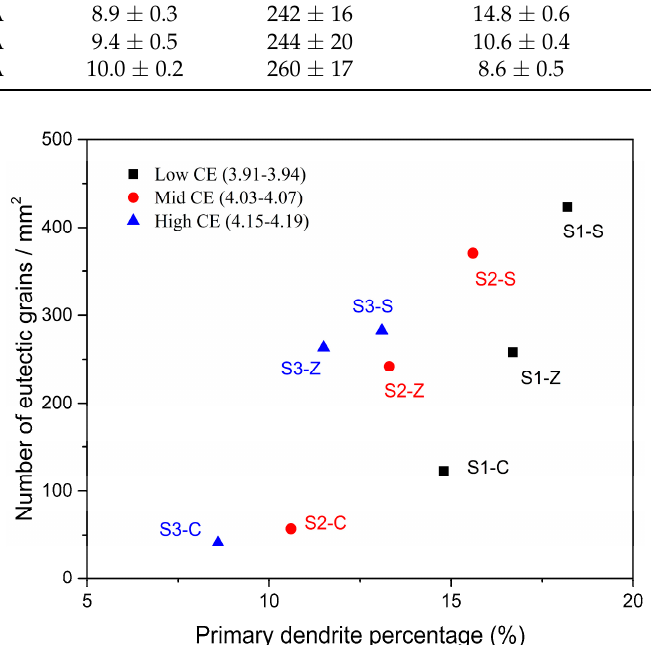
Figure 5. The primary dendrite percentage versus the number of eutectic colonies. Table 2. Microstructural characteristics of samples. Errors are ± one standard deviation.